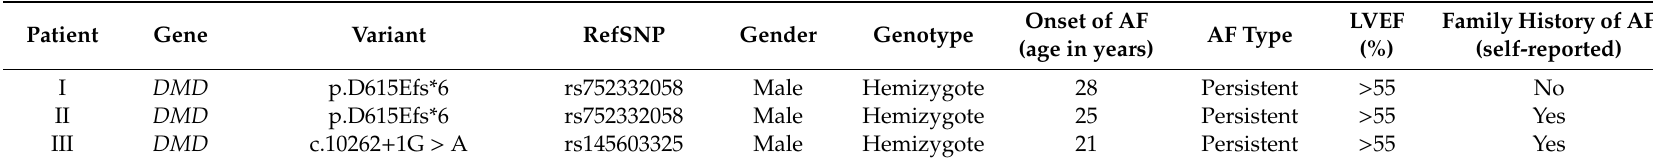
Table 2. Clinical characteristics of variant